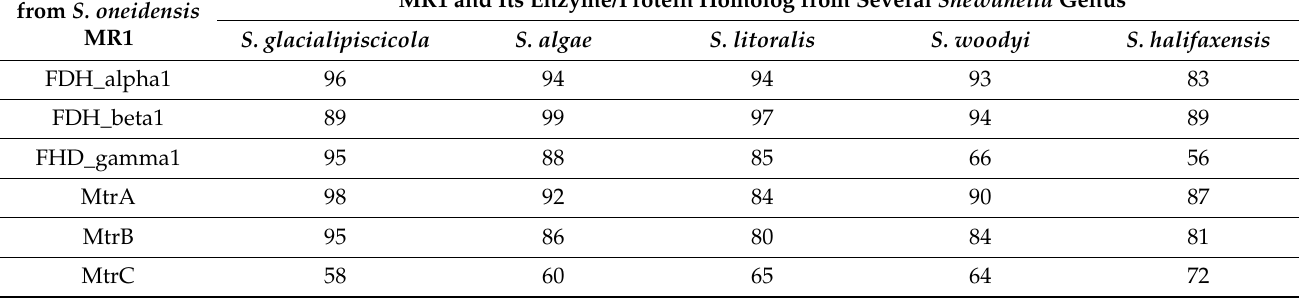
Table 3. Similarity (%) between formate dehydrogenases and electron-transporting proteins from S. oneidensis MR1 and corresponding enzymes/proteins from several Shewanella genus using CLUSTALX2 with